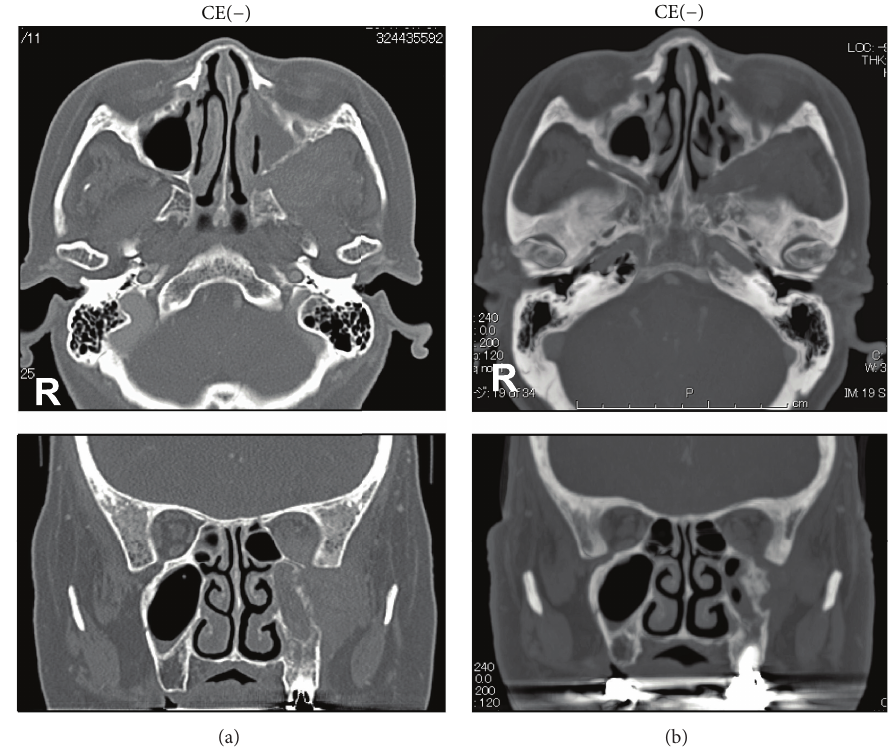
Figure 4: (a) Steroid therapy showed no change in the lesion. (b) Radiotherapy showed almost the entire lesion disappearing.